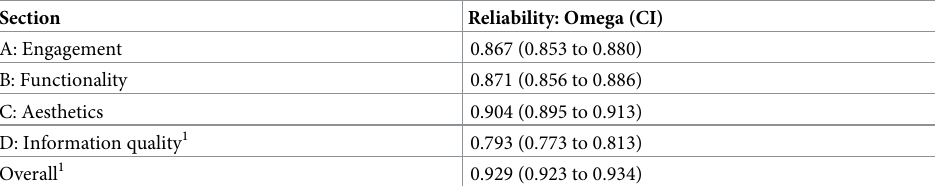
Table 3. Internal consistency of the MARS.